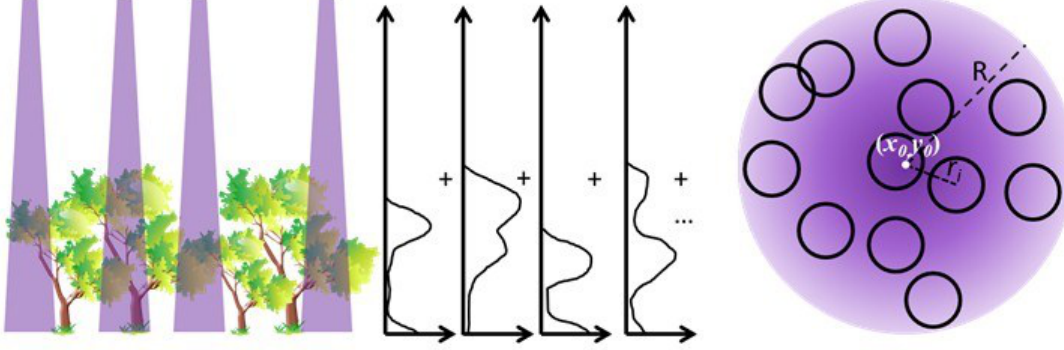
Figure 7. Illustration of the combination of lidar profiles to simulate a lidar signal of a larger footprint. R is the radius of the simulated larger footprint, r i is distance between i th laser shot and the simulated footprint center ( x 0 , y 0